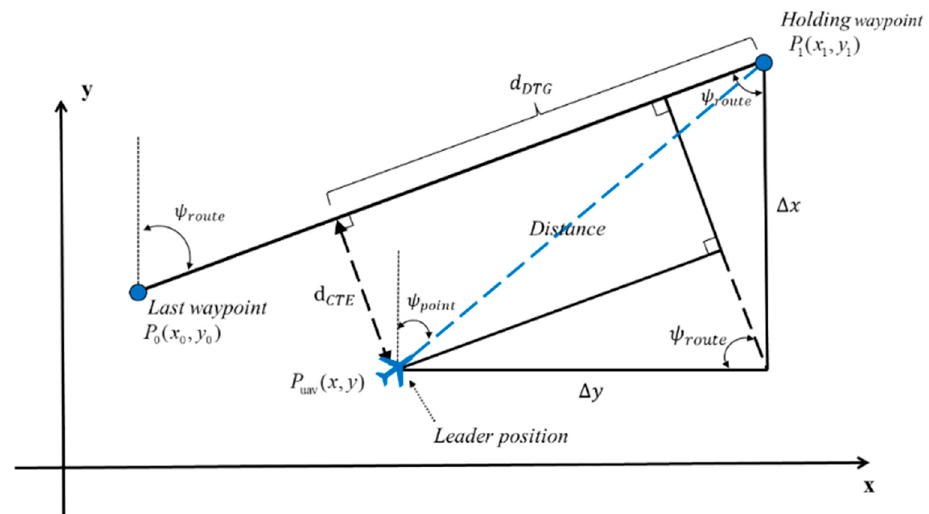
Figure 3. Linear guidance.